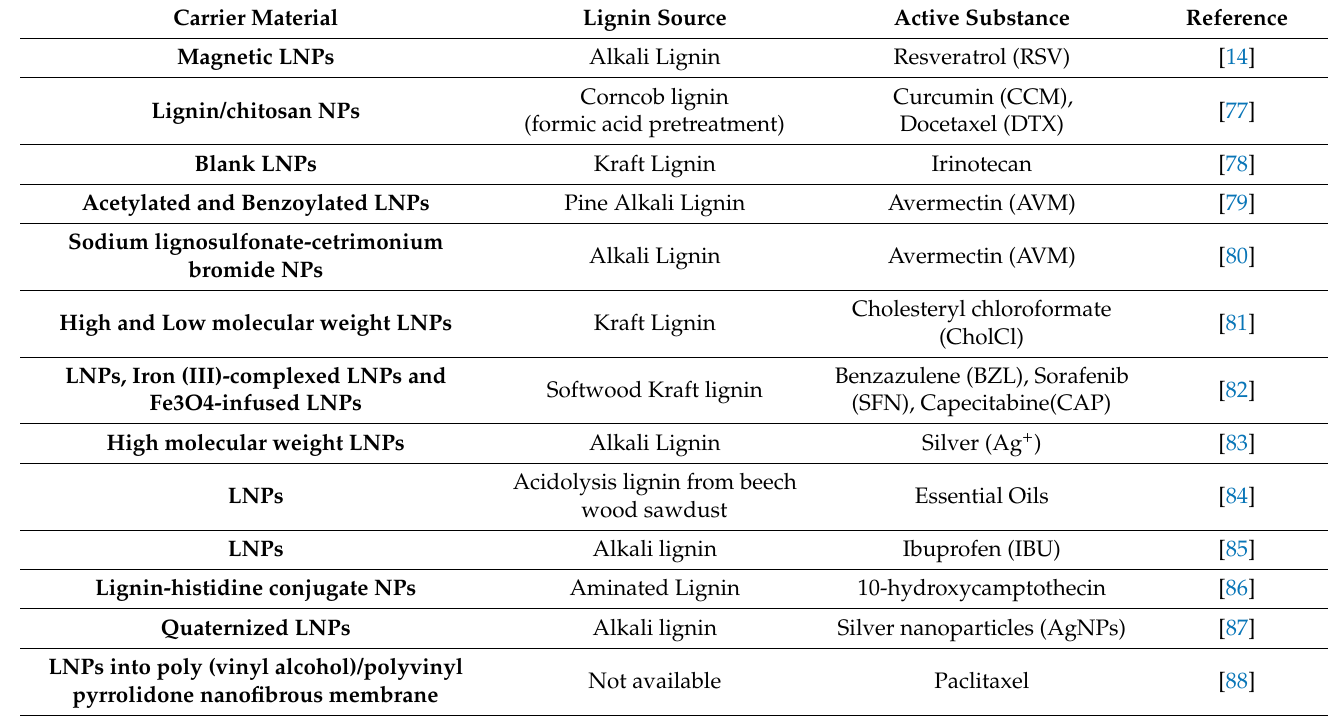
Table 1. Case studies of lignin biomedical